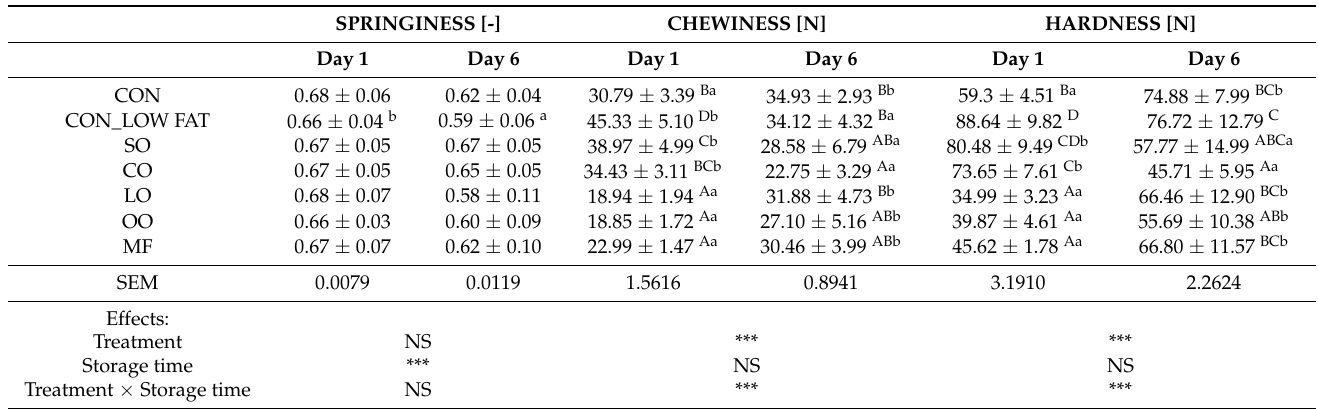
CON—control group beef burgers, CON_LOW FAT—burgers with reduced fat, burgers with fat substitutions, i.e., sunflower oil (SO), canola oil (CO), linseed (LO), olive oil (OO) and milk fat (MF). ( A–D )—means with different letters showing significant effect of treatment group in the same day of storage; ( a,b )—means with different letters showing significant effect of storage time in each treatment group; p ≤ 0.05. Effects *** p ≤ 0.001; NS—no significant; SE—standard error of the